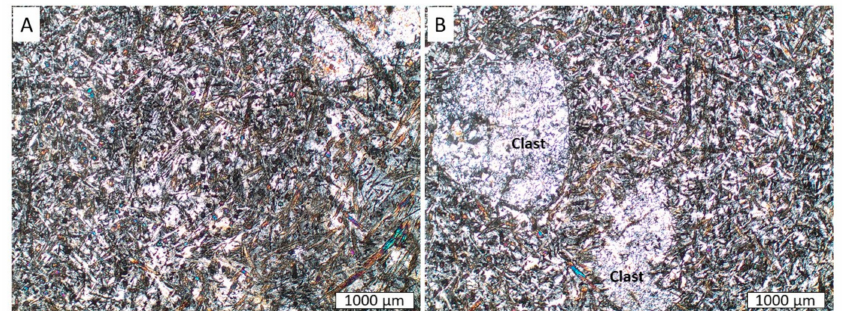
Figure 8. ( A , B ) Photomicrographs in crossed-polarized light (XPL) of the thin section representing typical HGD-S (fine-grained intersertal to porphyritic igneous texture as in [13]). The light domains are lithic clasts, predominantly composed of mosaic